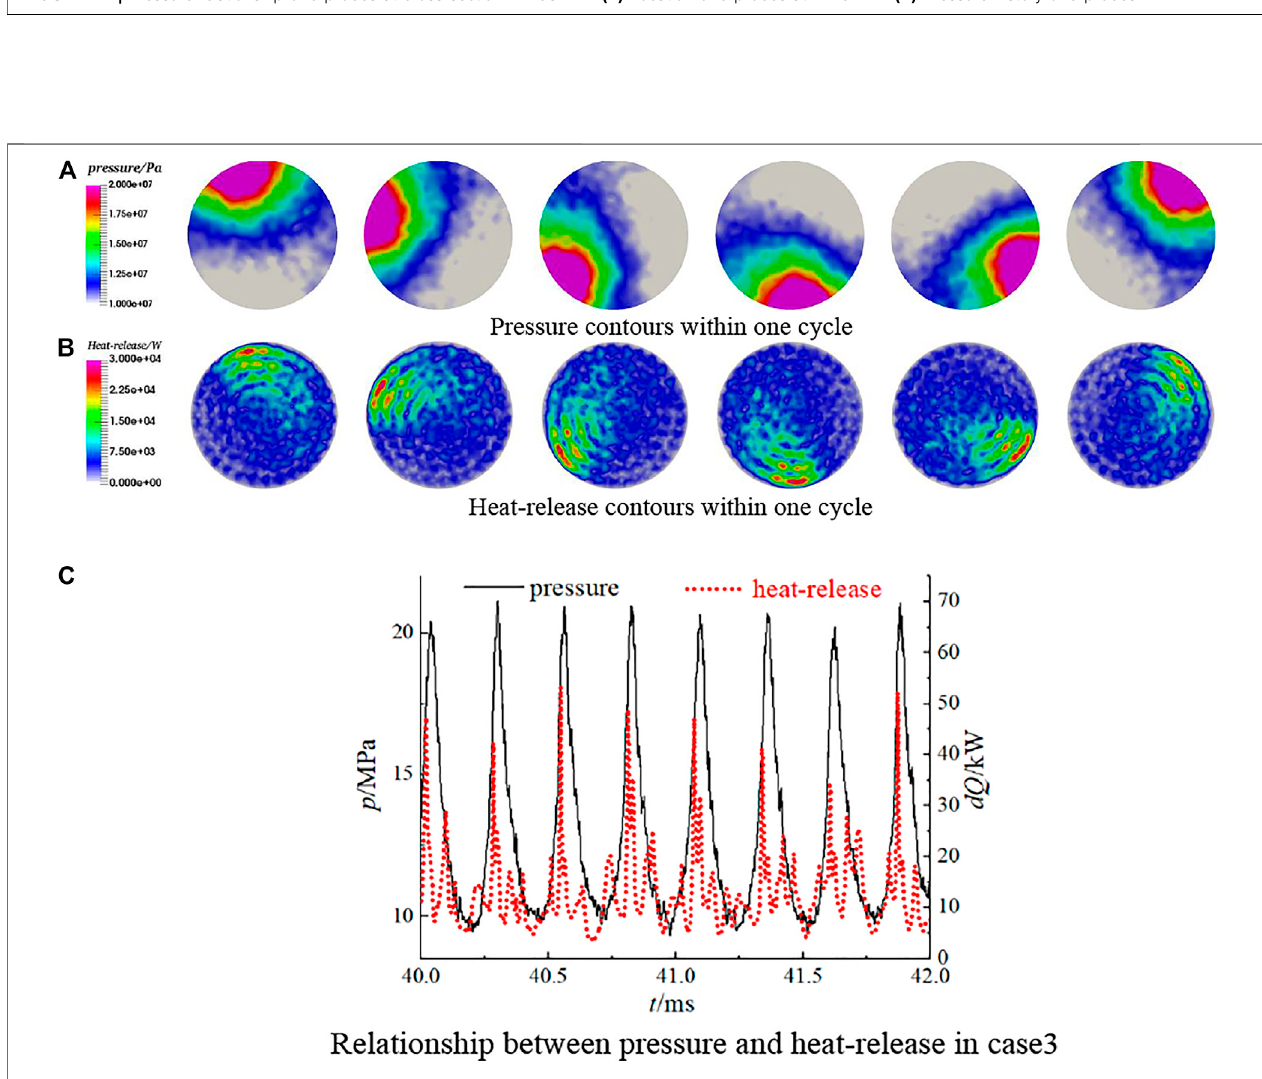
Frontiers in Energy Research |